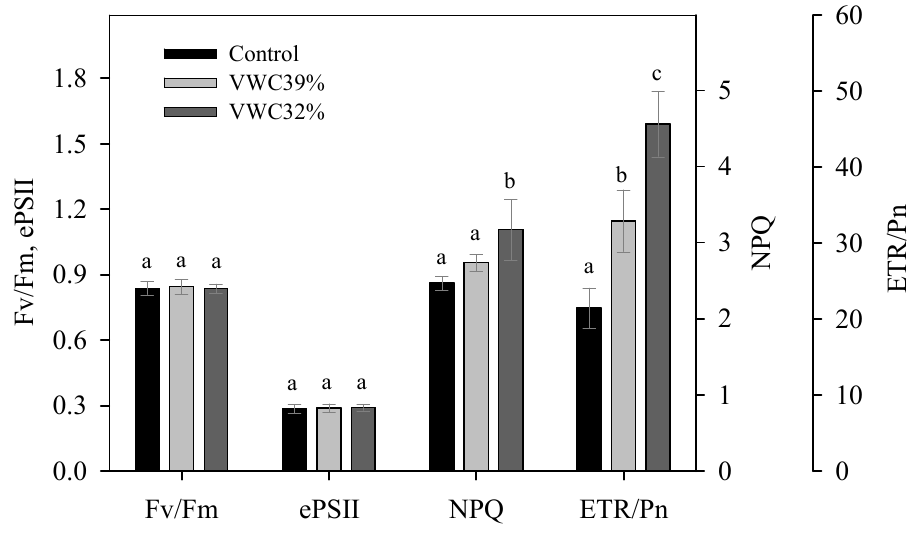
Figure 6. Effect of substrate moisture on several chlorophyll fluorescence parameters of Hebe leaves at the end of the experiment: maximum quantum yield of photosystem II (PSII) (Fv/Fm), effective quantum yield (ePSII), non-photochemical quenching (NPQ), and the ratio of the electron transport rate to the photosynthesis rate (ETR/P n ). Control (black), VWC39% (light gray), and VWC32% (dark gray) denote Hebe plants grown over 152 days at 49.28%, 38.44%, and 32.16% VWC, respectively. Values are means ( n = 5) and vertical bars indicate ± standard error. Different letters indicate statistically significant differences between means at p < 0.05 according to the least significant difference (LSD) test.